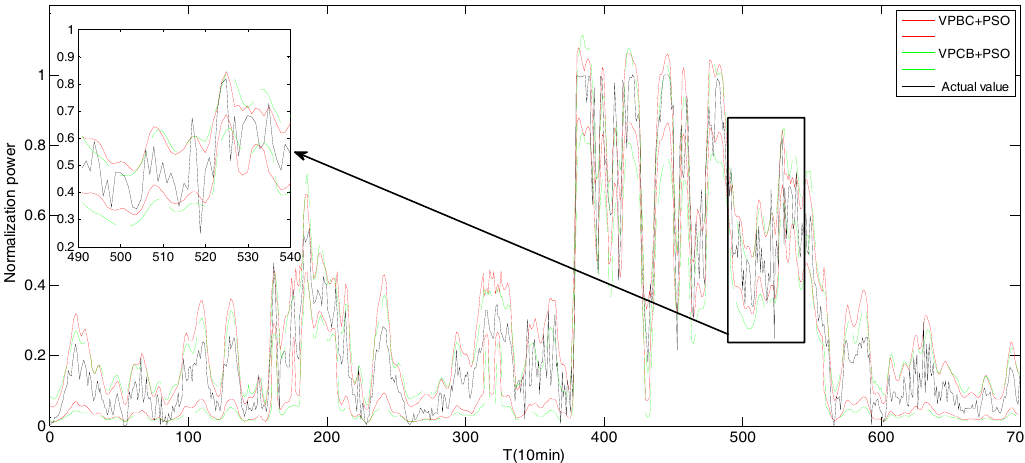
Figure 10. Forecasting results of the VPBC + PSO and VPCB + PSO methods at 80% PINC.